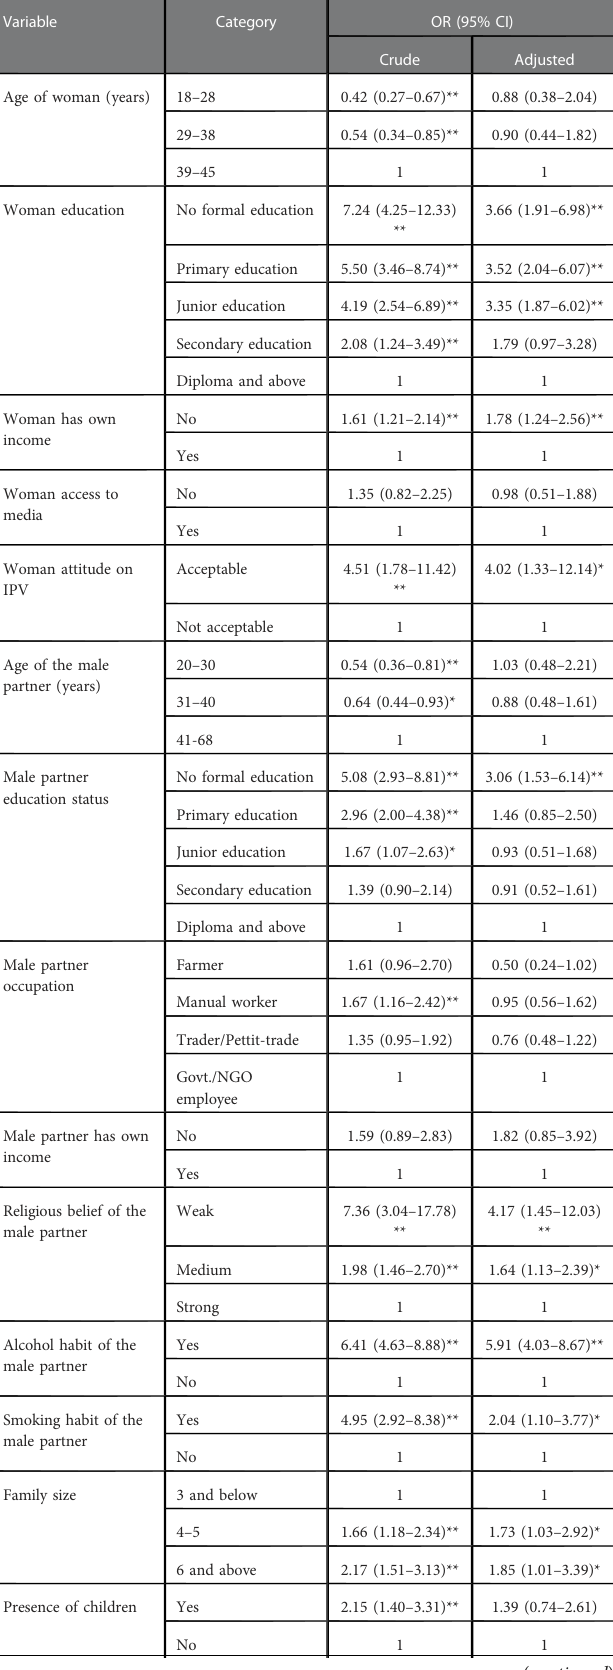
TABLE 8 Bivariate and multivariate logistic regression analysis of the association of selected risk factors with IPV among women of reproductive age in Debre Berhan, 2021 ( n